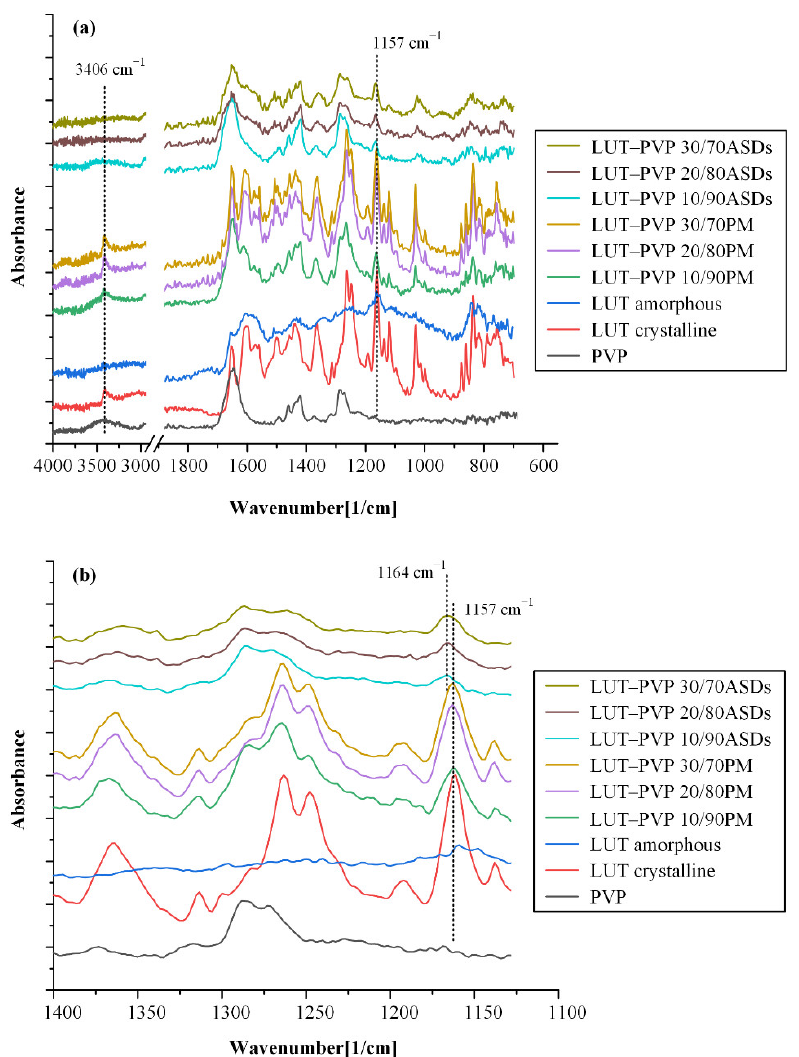
Figure 6. ATR-FTIR spectra of neat crystalline LUT, neat amorphous LUT, neat PVP, LUT-PVP physical mixtures (PMs), and ASDs at several drug-to-matrix/carrier-weight ratios from ( a ) 400–700 cm − 1 and ( b ) 1400–1100 cm − 1